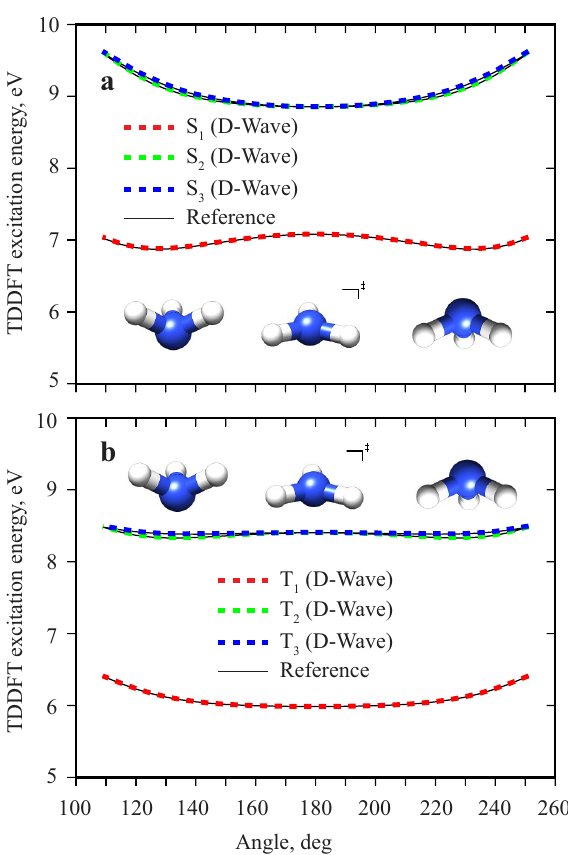
Figure 2. TDDFT excitation energies for the umbrella inversion of ammonia ( NH 3 ). Singlet ( a ) and triplet ( b ) calculations are shown separately. The first three excitation energies are computed using the QAE and D-Wave 2000Q quantum annealer (dashed red, green and blue curves). The reference calculation is shown for comparison (thin black curves). The angle is the improper H-N-H-H dihedral